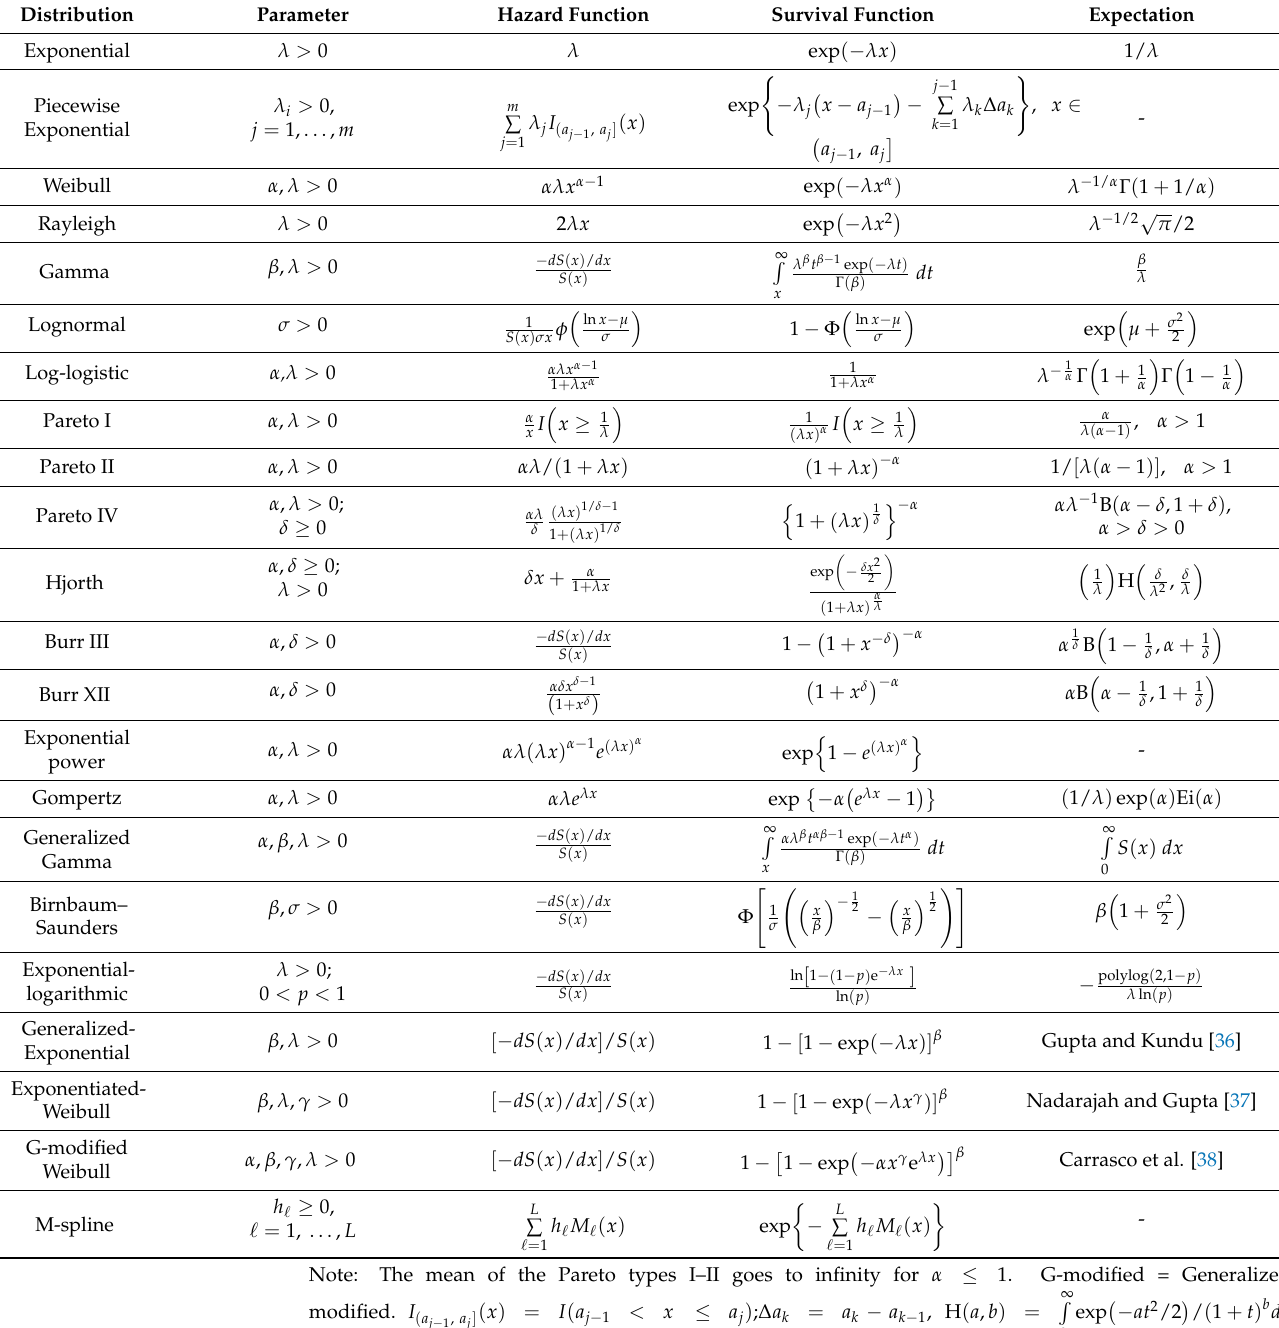
Table 1. Parametric distributions for survival and reliability